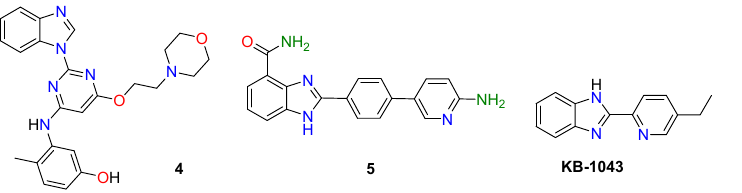
Figure 5. Selected examples of N-substituted or substituted at position 2 benzimidazole analogs bearing anti-inflammatory properties.